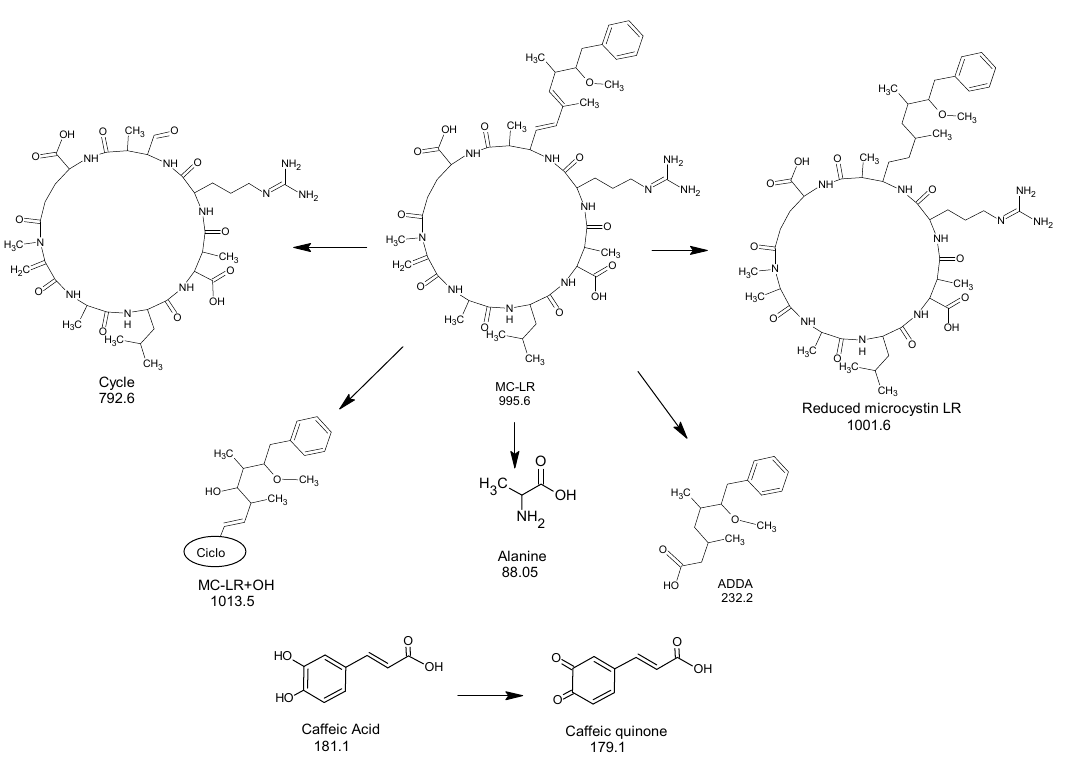
Figure 6. A proposed oxide-reductive pathway of the decomposition of MC-LR with caffeic acid.